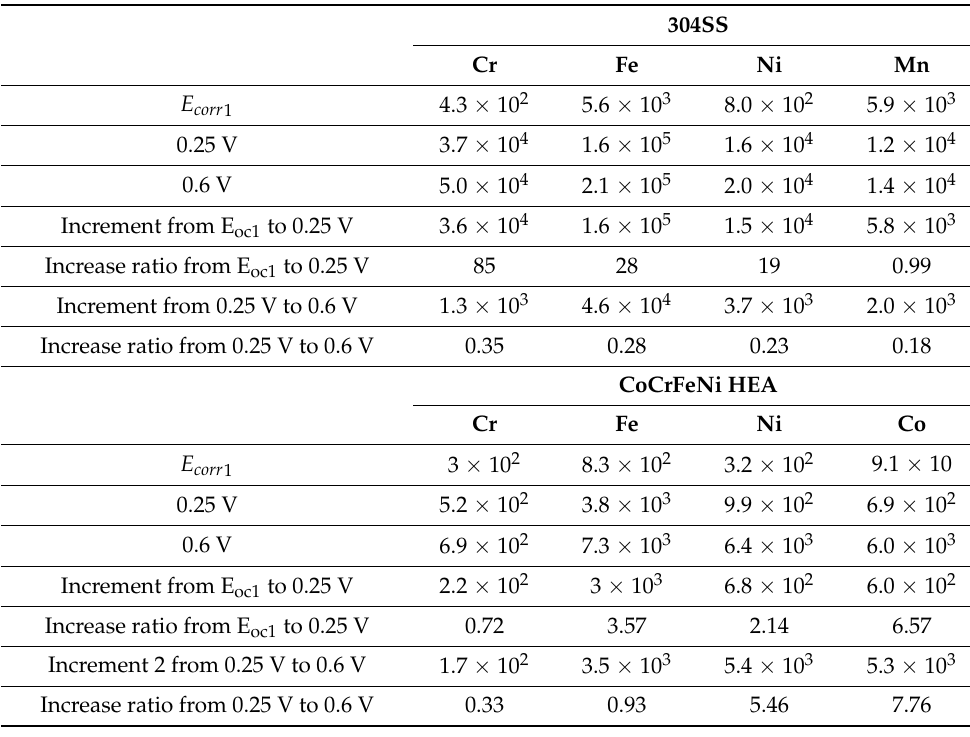
Table 5. The dissolved ion concentrations (ppt) of 304SS and (CoCrFeNi HEA at the potentials